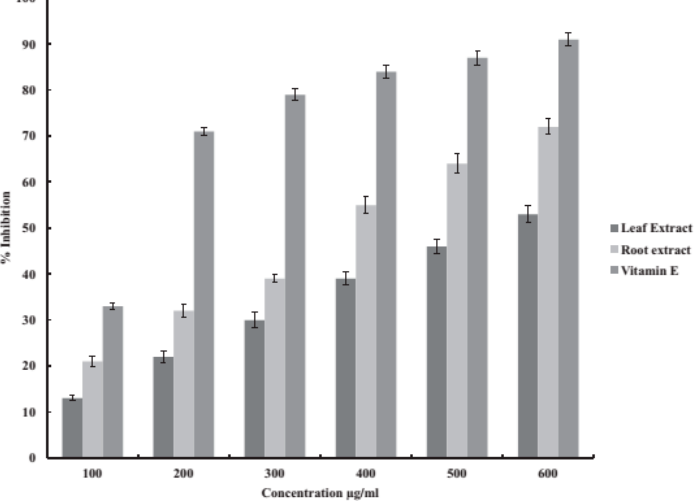
Figure 3. Free radical scavenging activity of methanolic extracts of leaves and roots of G. kurroo Royle (Source: [59]).